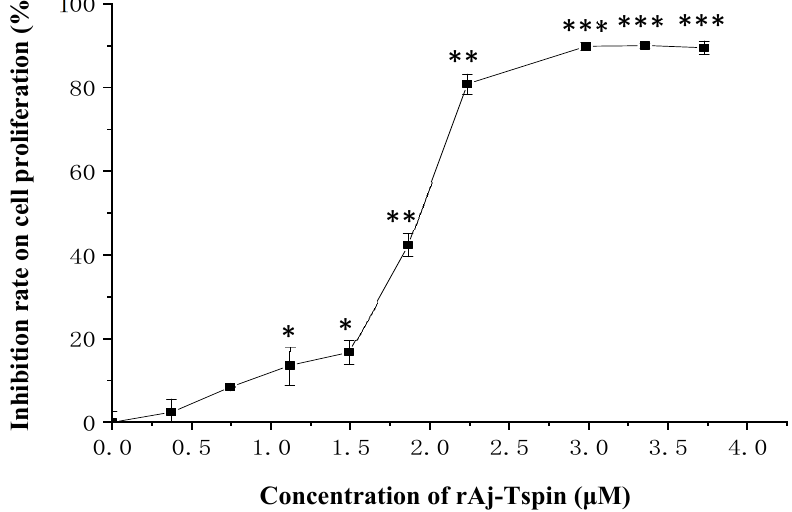
Figure 5. CCK-8 assay detected the inhibitory effects of rAj-Tspin on the proliferation of LLC cells. *, ** and ***, respectively, indicate p < 0.05, p < 0.01, and p < 0.001 (compared with control group). Each assay was repeated three times.